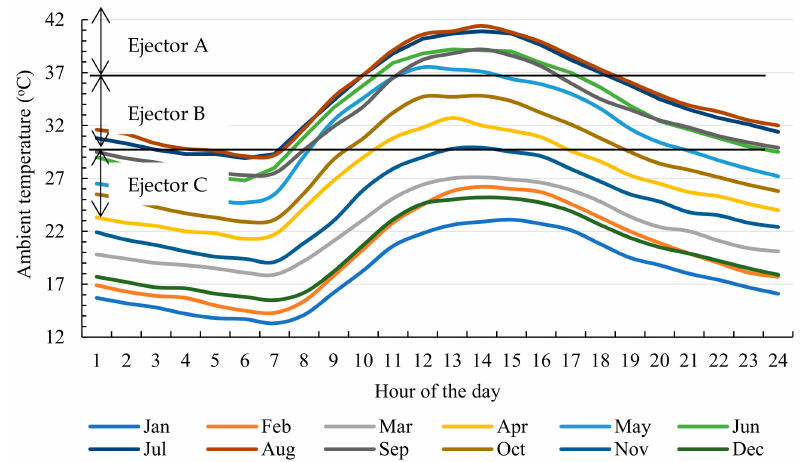
Figure 3. Monthly average hourly ambient temperature distribution in Abu Dhabi, UAE (24 ◦ 28 (cid:48) N 54 ◦ 22 (cid:48) E), based on the TRNSYS TMY2 database [23], with the range of activation of refrigeration sub-system Ejector A, B, and C branches (Figure 1b) also